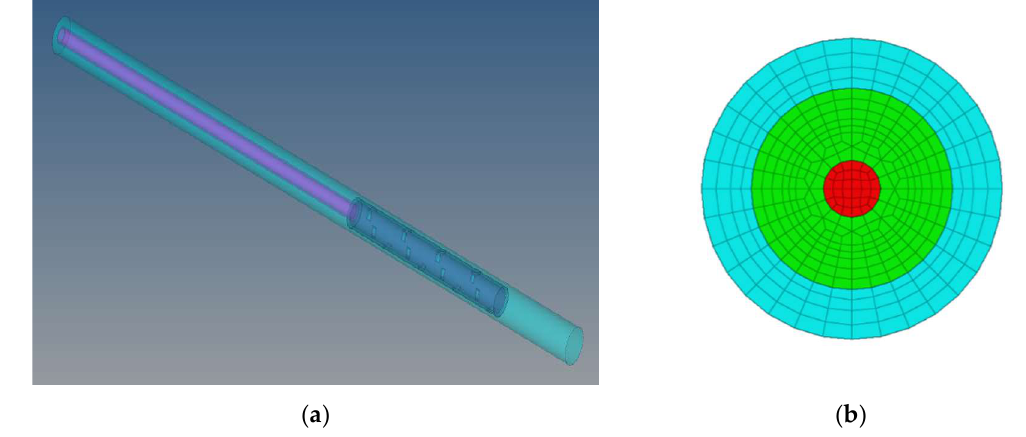
Figure 5. Modeling and meshing: ( a ) model for numerical simulation; ( b ) cross-section view of mesh model.